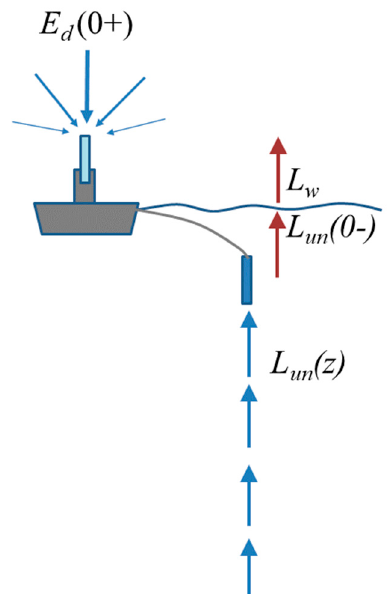
Figure 4. Schematic of underwater vertical profile measurements. This sketch shows deployment typical of a free-fall radiometer tethered to a ship, although the method is generic and does not need to be ship-tethered, e.g., could be tethered to a fixed offshore platform or moored buoy, or could be untethered and horizontally drifting, while profiling.